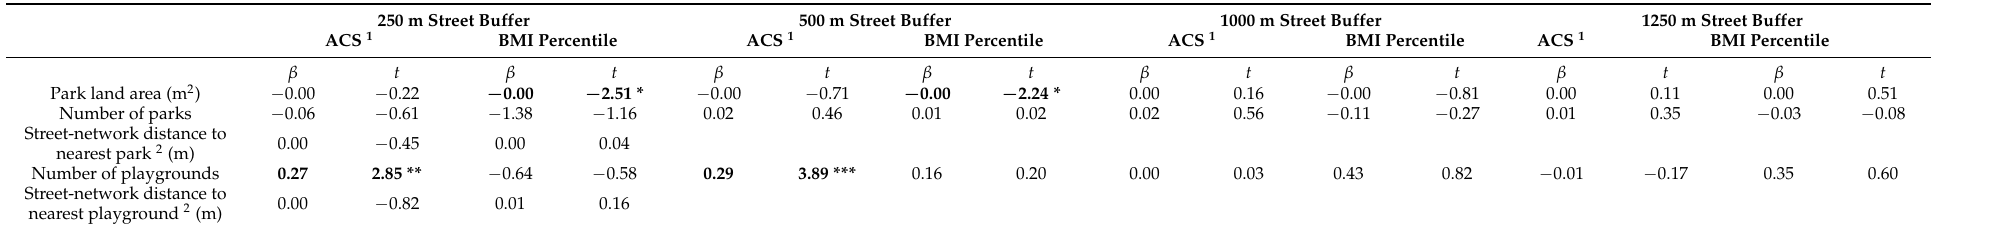
Table 5. Mixed-model regression results for the relationship between the availability and proximity to parks and playgrounds in the participants’ neighborhood and active commuting to/from school (ACS) and BMI